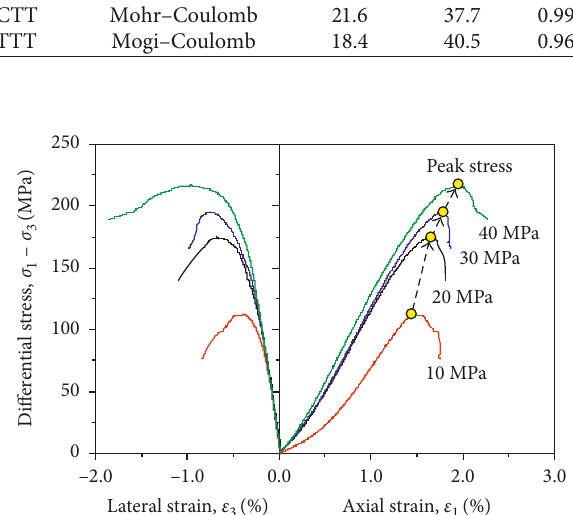
Figure 5: Stress-strain curves for sandstone from conventional triaxial compression